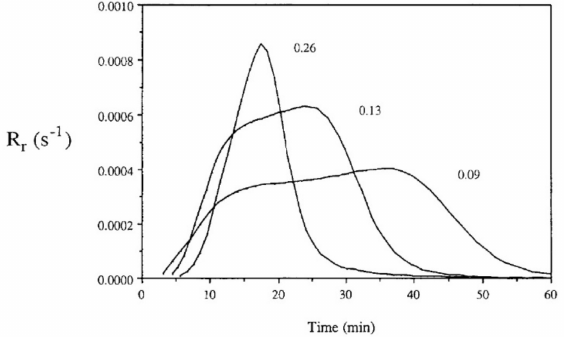
Figure 15. Polymerization rate R r versus time for various mixtures of vinyl ester resin and styrene with labels corresponding to the crosslinker concentration. Reprinted from reference [85] with permission of John Wiley and